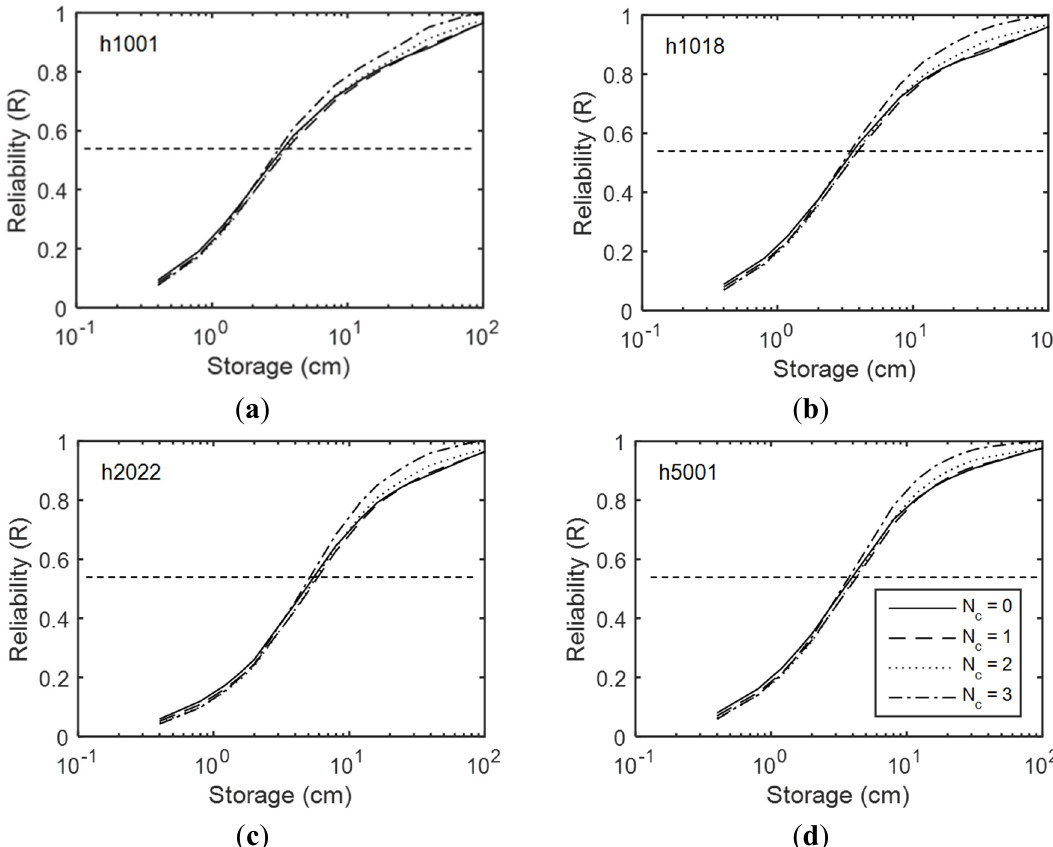
Figure 4. Reliabilities of the four RBSNs under the historical rainfall (1970 − 1999) for the test catchments ( a ) 1001; ( b ) 1018; ( c ) 2022 and ( d )